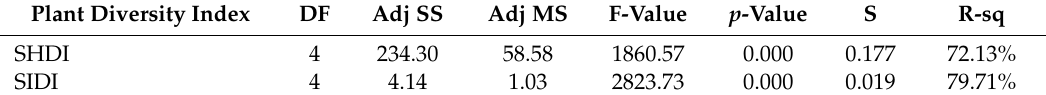
Table 7. General linear analysis of vegetation structure and plant diversity index. Plant Diversity Index